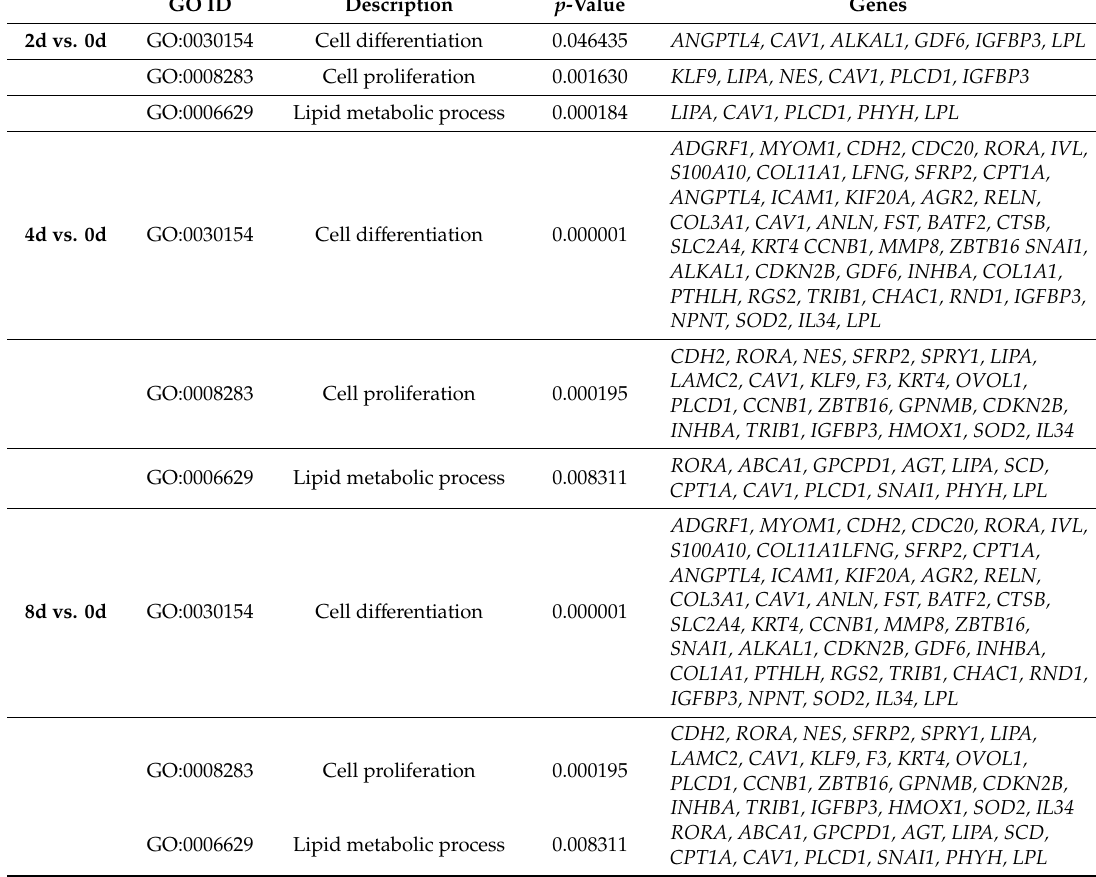
Table 3. Summary of Gene Ontology (GO) analysis of di ff erentially expressed genes (only significant terms listed).